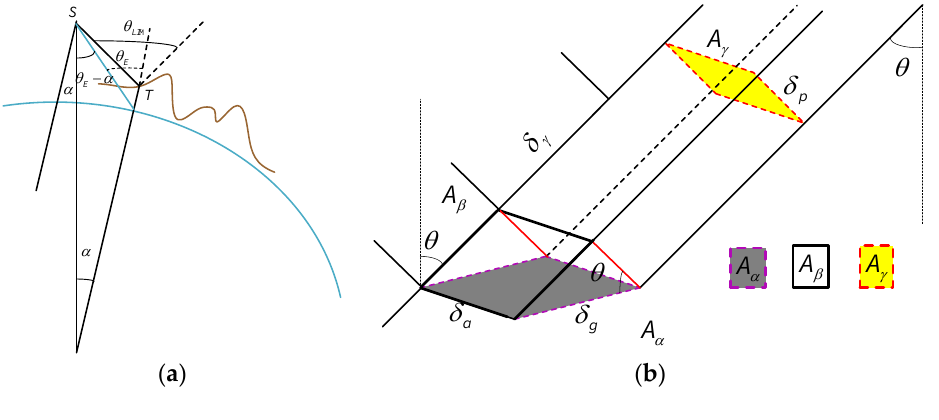
Figure 1. Terrain of vegetation area in SAR image: ( a ) SAR imaging geometry; and ( b ) SAR backscattering.